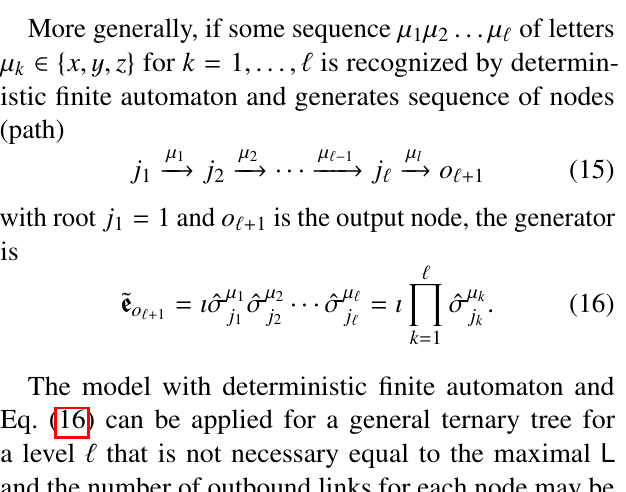
Figure 2: Deterministic finite automaton (DFA) from ternary Υ -tree extended by leaf L